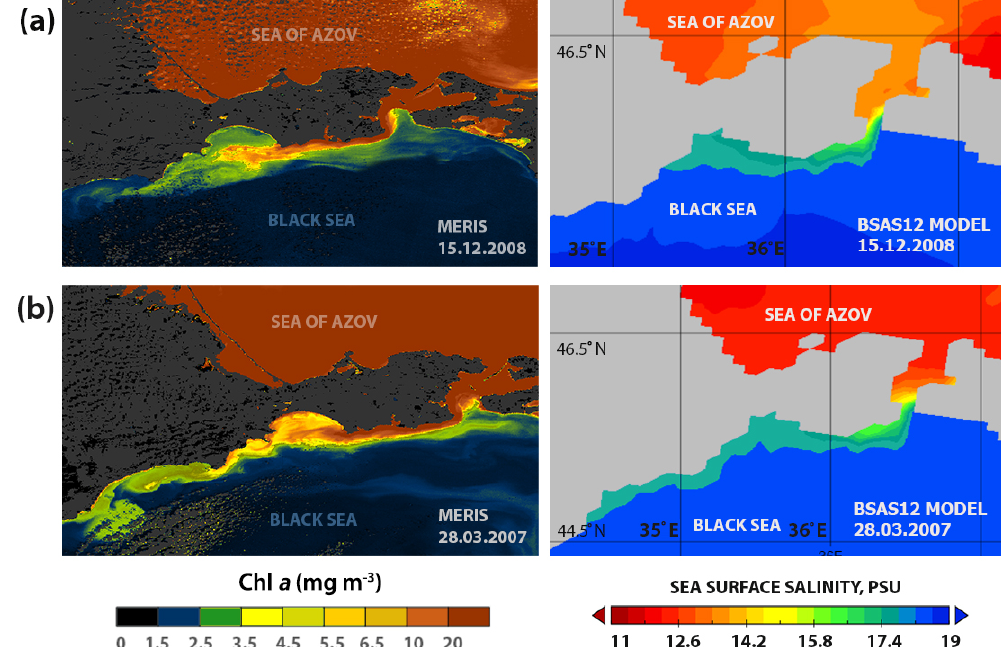
Figure 7. Sea surface distribution of Chl a retrieved from MERIS satellite data (left) and sea surface salinity distribution obtained from numerical modelling (right) on (a) 12 December 2008 and (b) 28 March